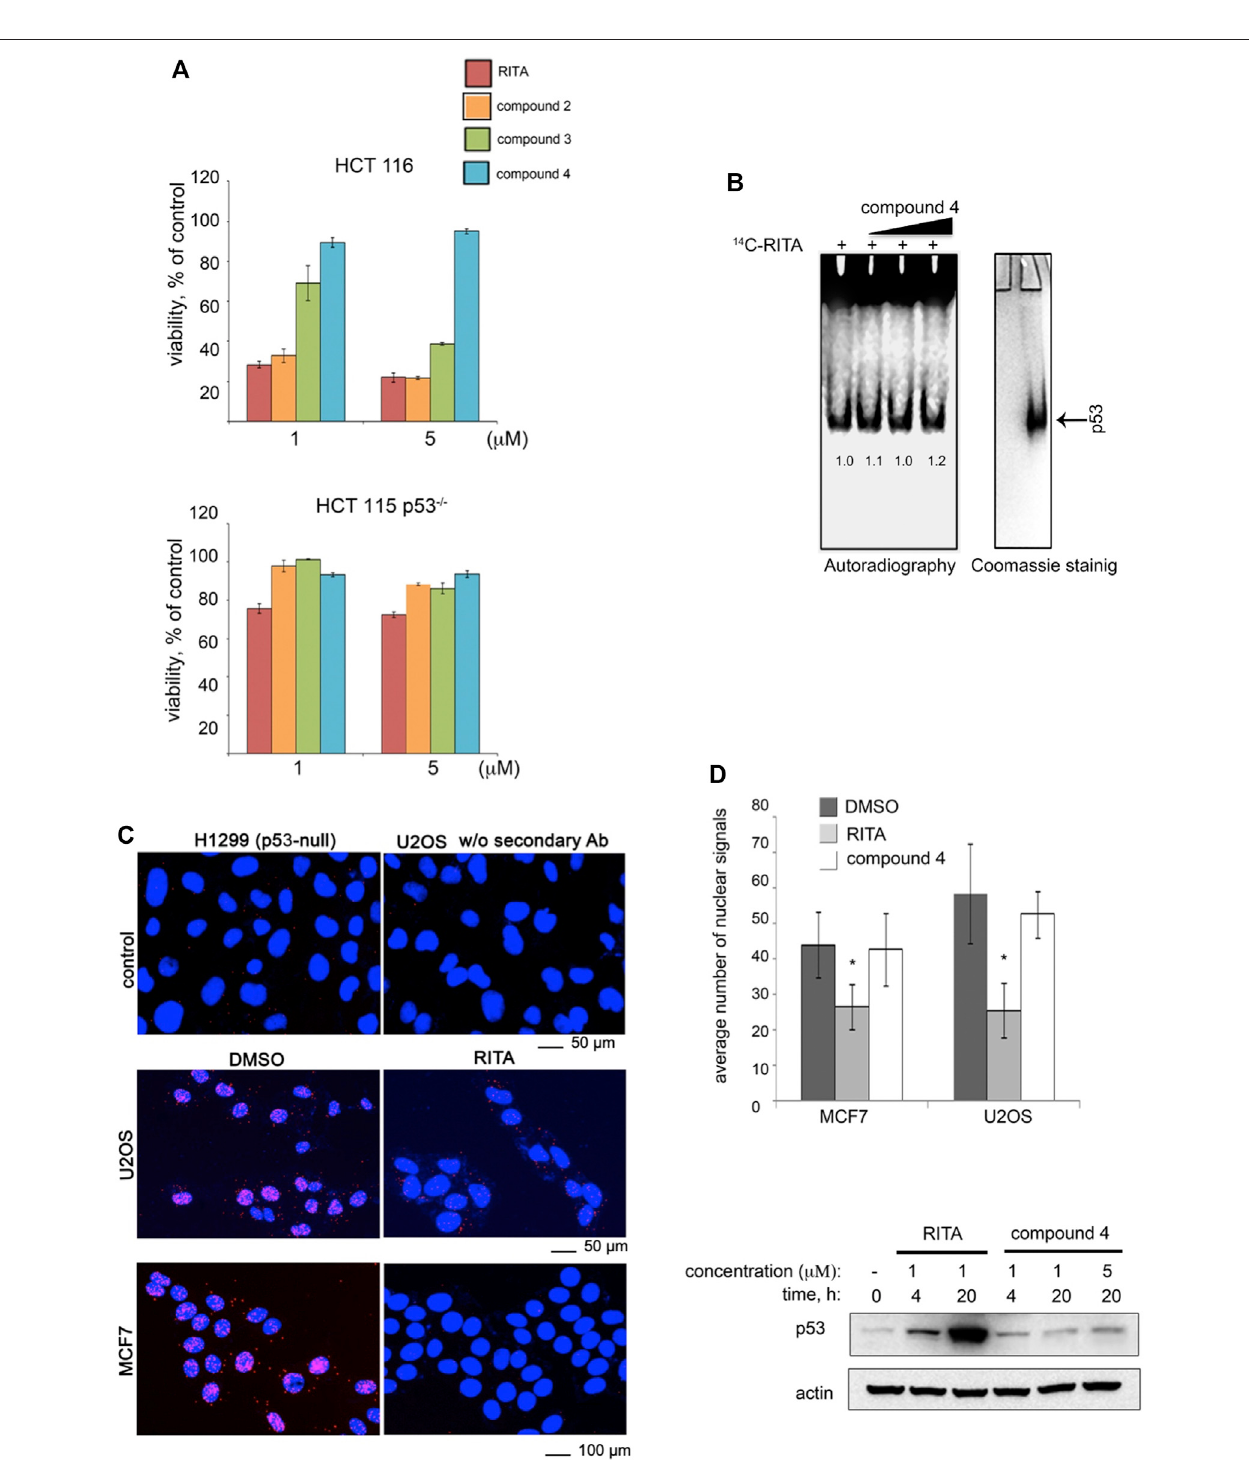
FIGURE4| TwoterminalhydroxylgroupsofRITAarecrucialforthebindingtop53andtheinhibitionofthep53/MDM2interaction. (A) RITAanalogueNSC-650973 (compound 4) lacking two hydroxyl groups does not inhibit the growth of HCT 116 cancer cells, unlike LCTA-2081 (compound 2) analogue with substituted O atom in furan ring (for structure refer to Supplementary Table S1 ), which retained full biological activity. NSC-672170 (compound 3) analogue with one hydroxyl group substitutedtoketoneretainedapproximately60%ofRITAbiologicalactivity. (B) Compound4(40,80,and100 µM)doesnotcompeteforthebindingtoNp53with [ 14 C]-RITA. (C) p53/MDM2complexes( fl uorescentfoci)inMCF7andU2OScellstreatedornon-treatedwithRITAasdetectedby insitu ProximityLigationAssay(isPLA). The p53-null H1299 and U2OS cells stained without secondary antibody were used as the assay controls. (D) Quantitative isPLA demonstrated the decrease in the average number of nuclear signals by RITA, but not by its derivative NSC-650973 (cpd 4) (upper panel). The normality was assessed with Shapiro-Wilk ’ s test. p < 0.05 values were considered statistically signi fi cant. RITA, but not compound 4 induced p53 accumulation in HCT116 cells, as detected by western blot (lower panel).